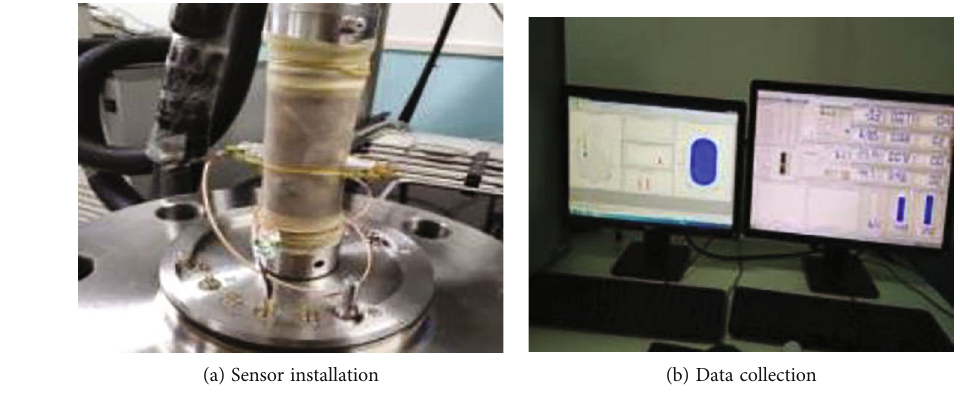
Figure 3: Sensor installation and data acquisition. Table 1: Changes in the physical parameters of red sandstone after freeze-thaw